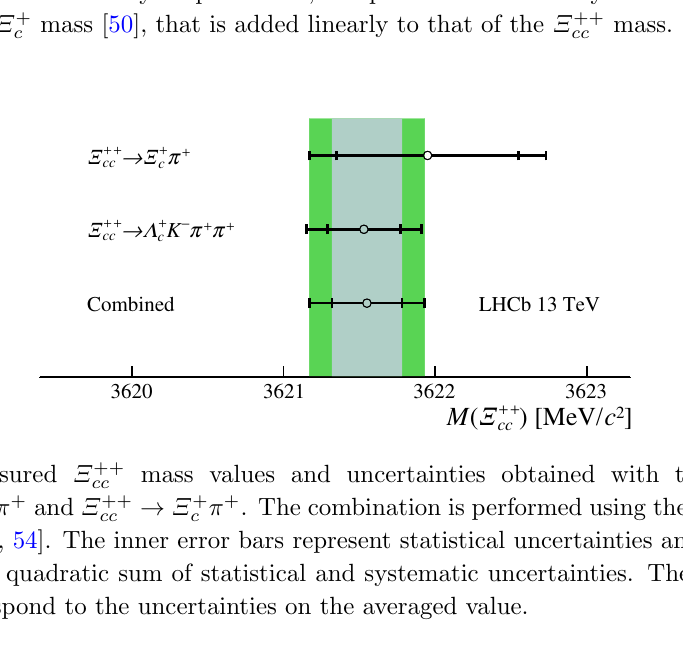
! (cid:3) + K (cid:0) (cid:25) + (cid:25) + and cc c mass. cc